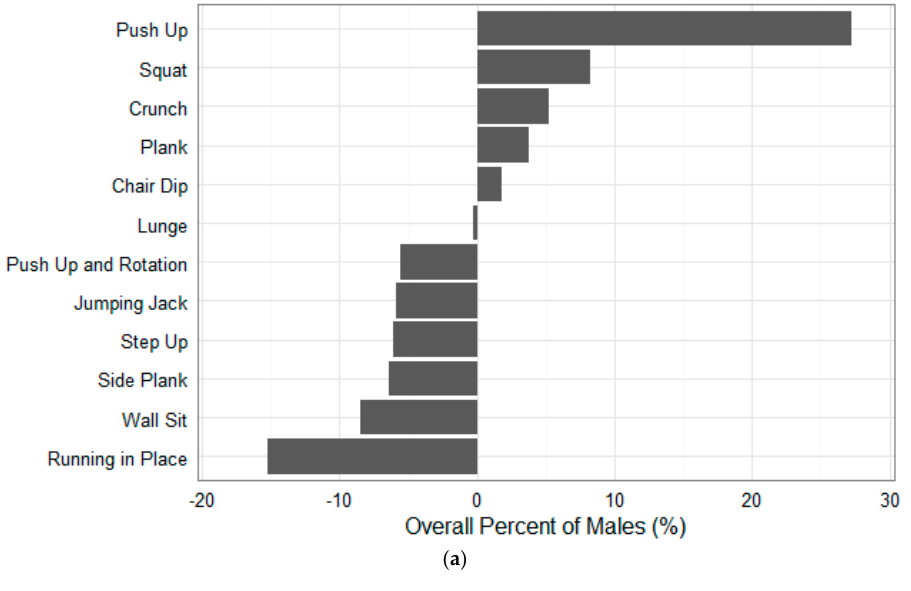
Table 3. Overall preference for each of the twelve exercise types. Positive overall preference indicated that the percentage of participants that chose the exercise as most preferred was higher than the percentage of participants that chose the exercise as least preferred. The reverse was the case for the negative overall